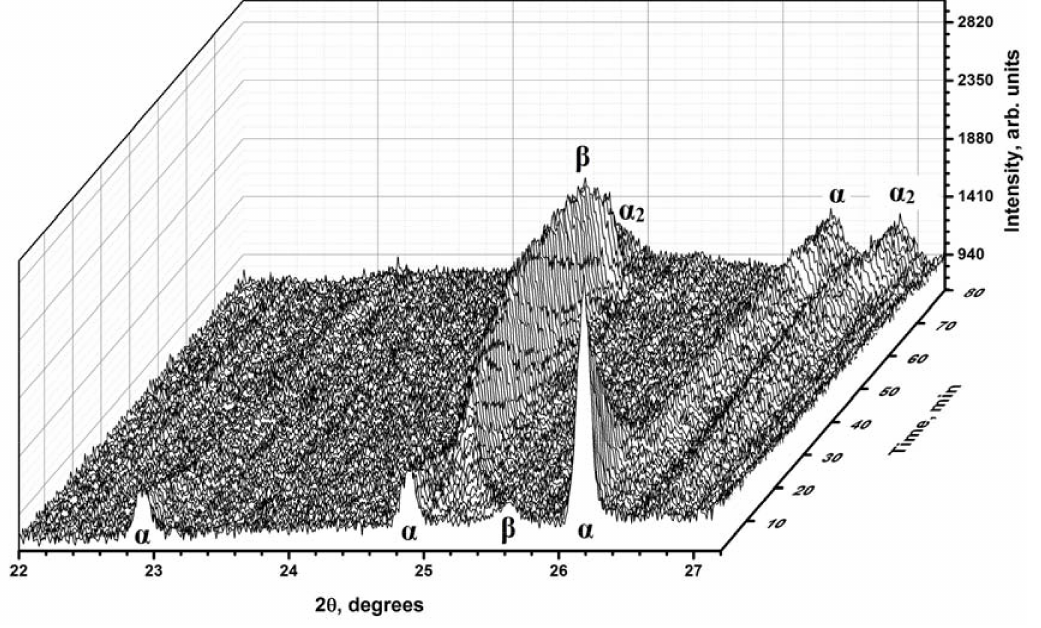
Figure 2. The phase transitions in Ti-6Al-4V parts produced by EBM during hydrogenation at 650 ◦